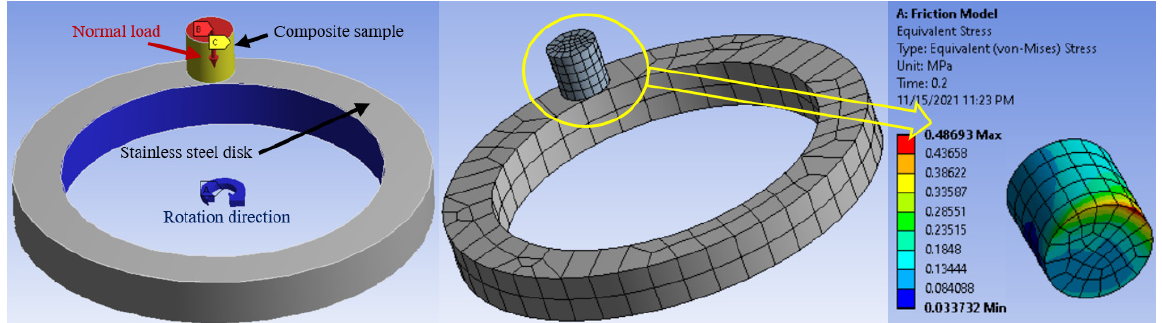
Figure 8. Friction coefficient of epoxy/corn cob composites with different sliding distances.